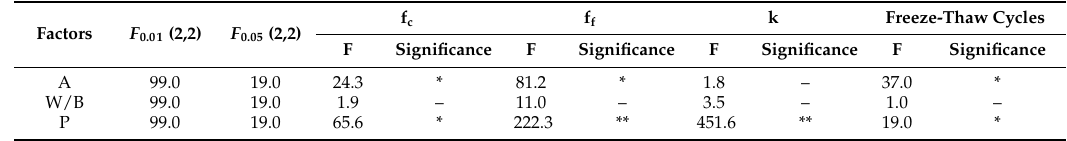
Table 6. Variance analysis for properties of